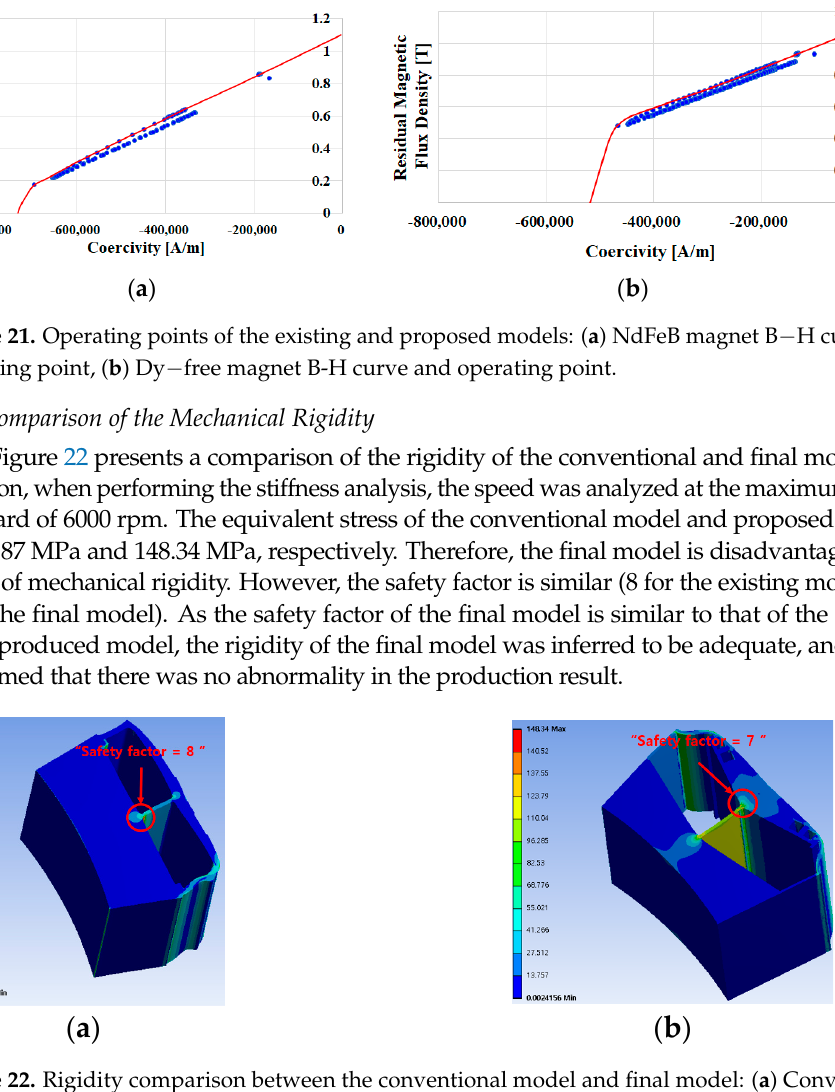
Figure 21. Operating points of the existing and proposed models: ( a ) NdFeB magnet B − H curve and operating point, ( b ) Dy − free magnet B-H curve and operating point